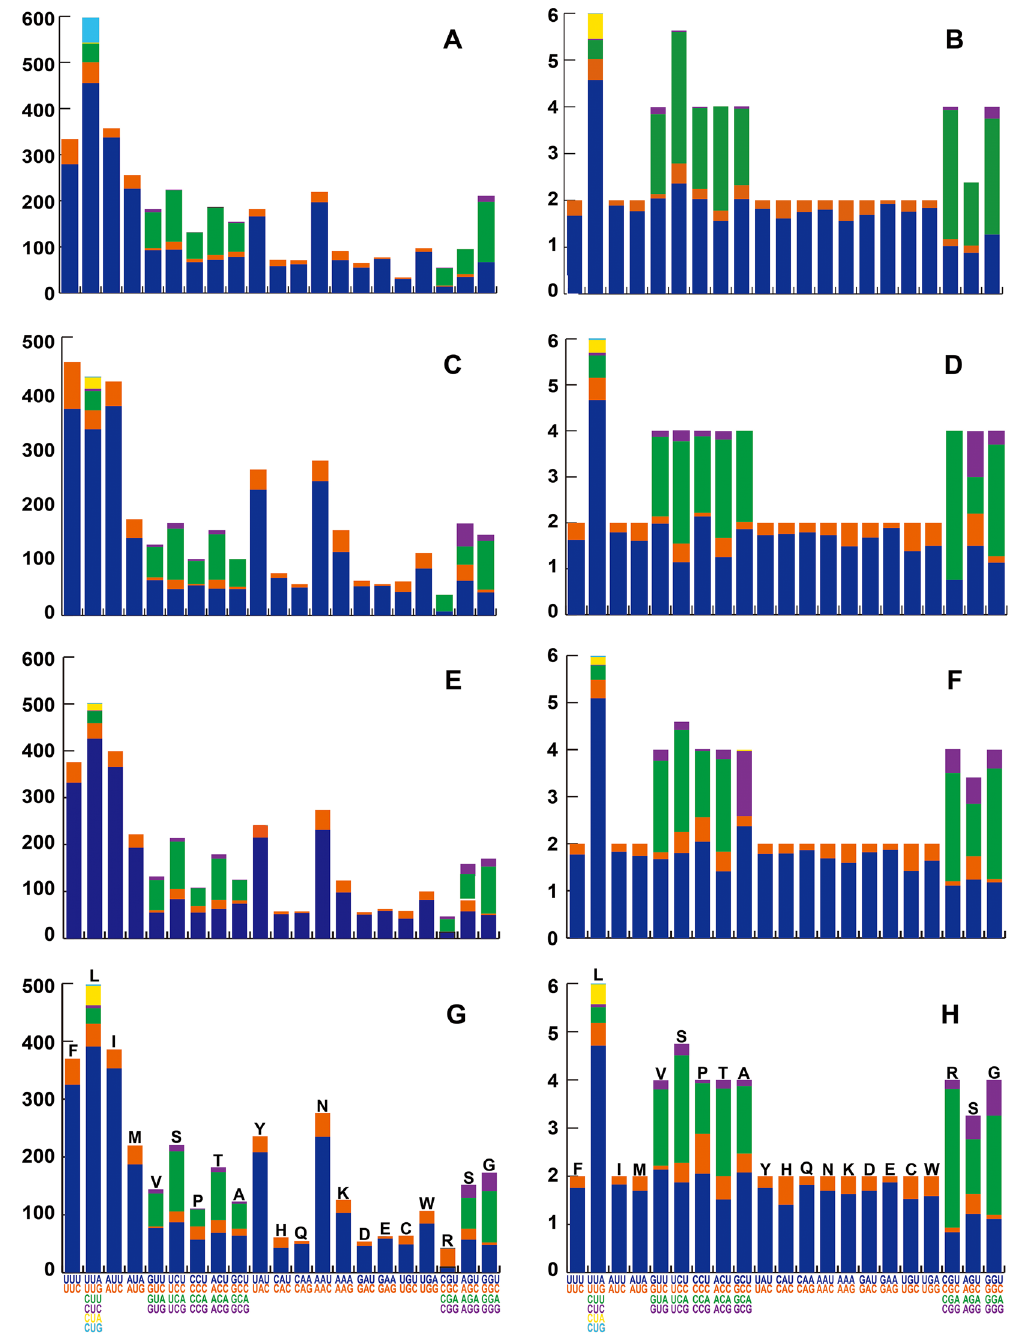
Figure 2. The codon usage ( A , C , E , G ) and Relative Synonymous Codon Usage (RSCU) ( B , D , F , H ) in the mitogenomes of Eristalinus . ( A , B ) E. viridis , ( C , D ) E. quinquestriatus , ( E , F ) E. sp., ( G , H ) E . tarsalis . The code color in the horizontal axis corresponds to the same color in the Figures. The image was computed by MEGA 6.0 (http:// www. megas oftwa re. net/ previ ousVe rsions.